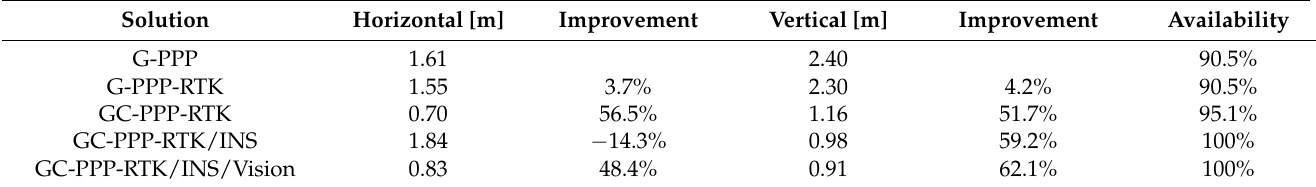
Table 4. RMS of the positioning error of T02 in horizontal and vertical directions, respectively.